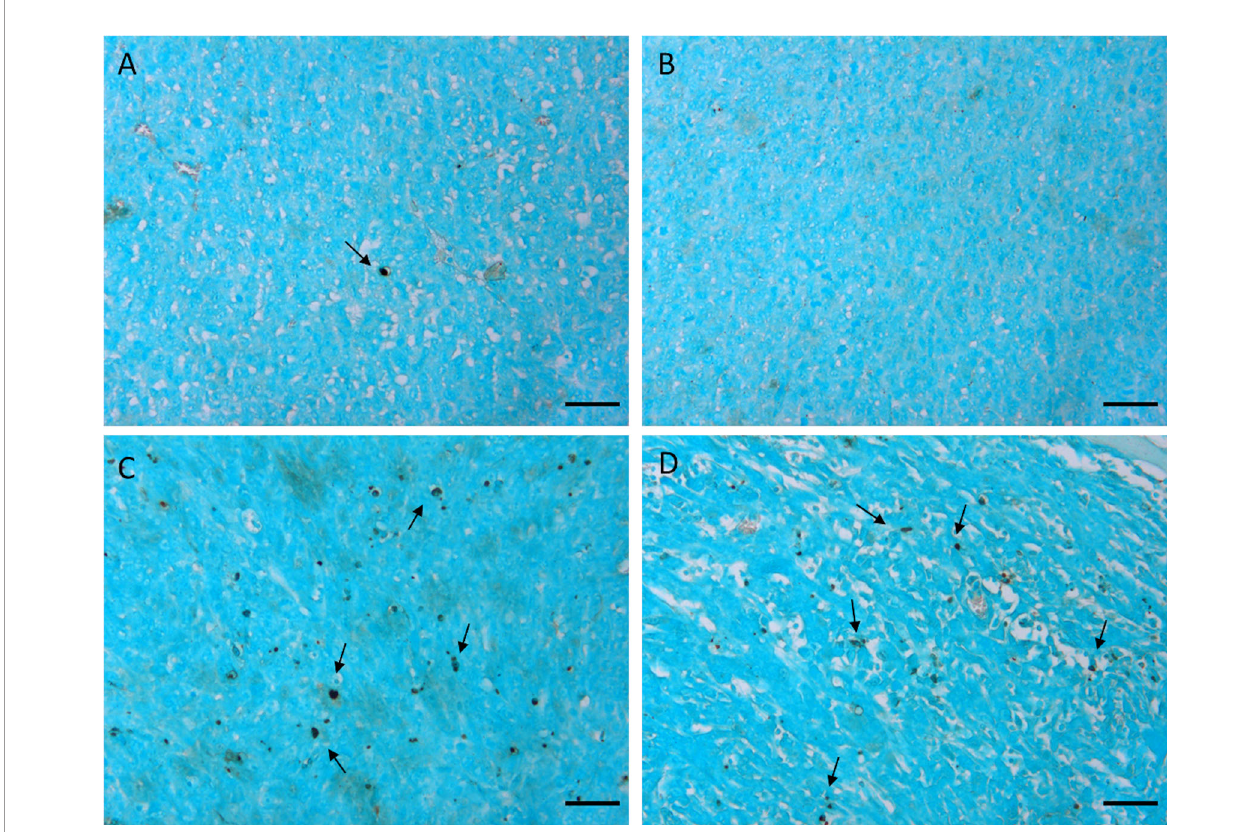
FIGURE 6 | TUNEL staining of 4T1 tumors excised 3 days after the fi rst treatment. Representative images of tumors treated with the vehicle (0.9% saline solution) (A, B) and with doxorubicin 5 mg/kg (C, D) . Arrows indicate apoptotic nuclei. Cells were counterstained with methyl green. Scale bars= 50 µm ”